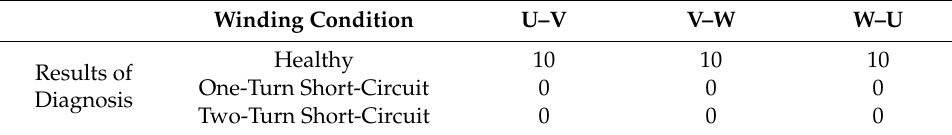
Table 7. Diagnostic results for the 2.2-kW motor 2 (healthy).